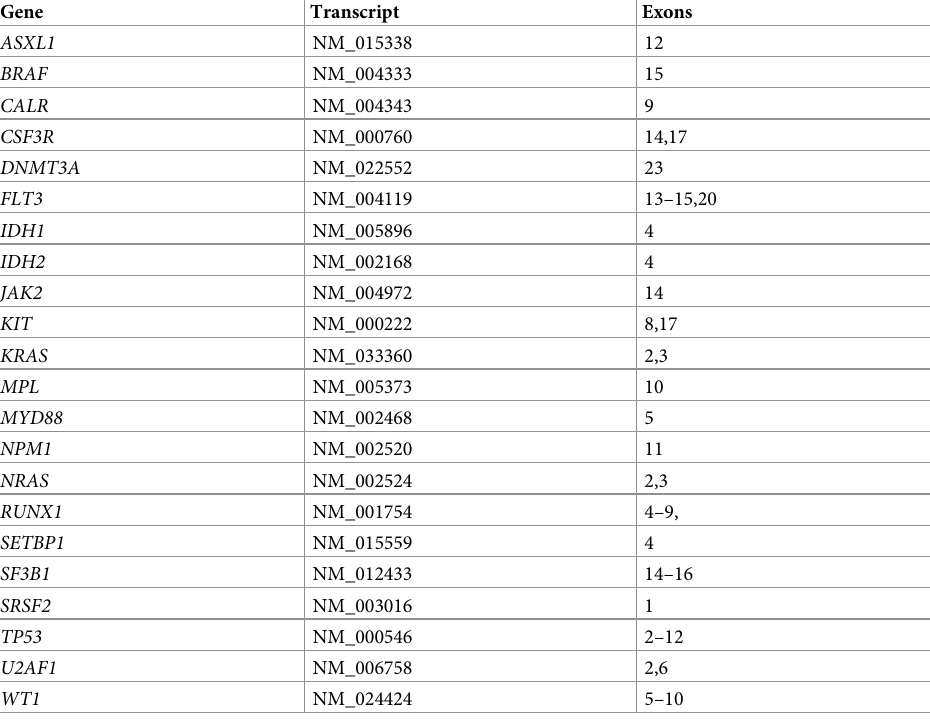
Table 1. The genes and exons covered in the NGS MRD panel.